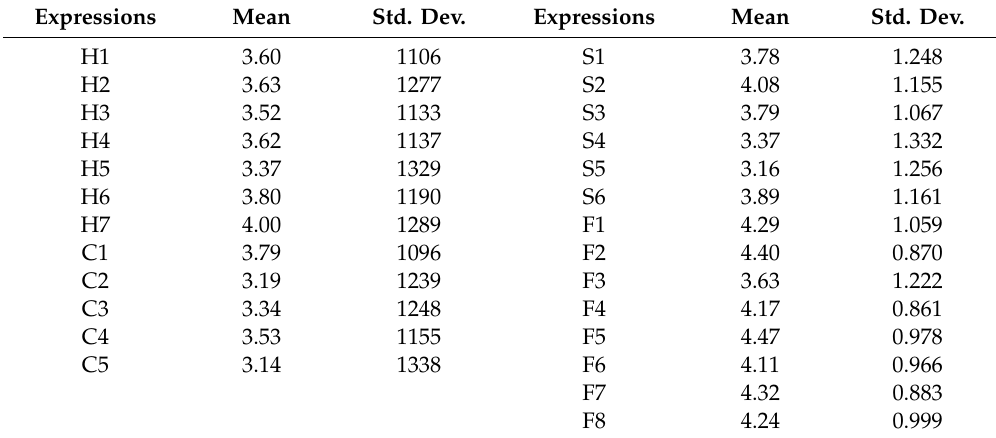
Table 2. Averages and standard deviations for the